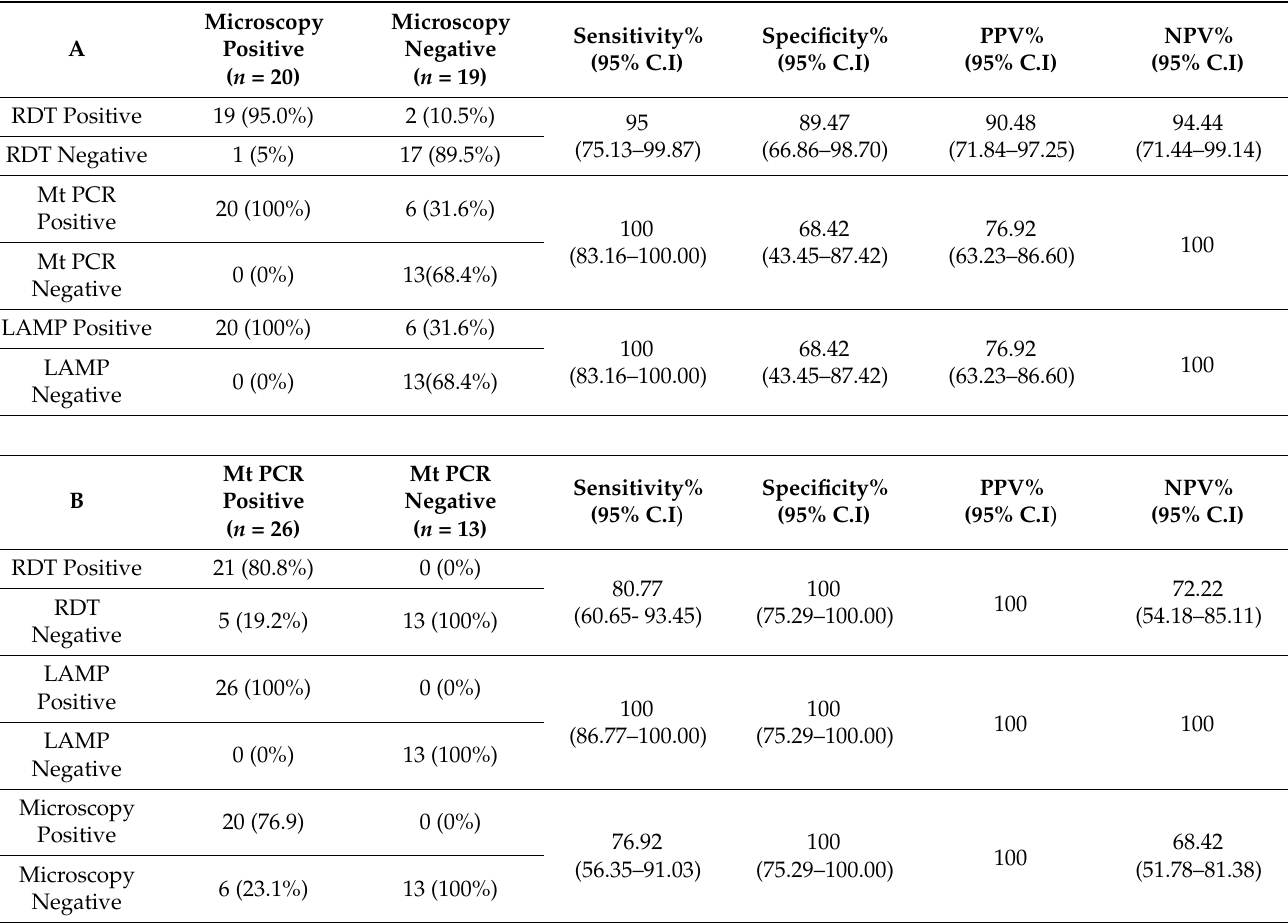
Table 3. Sensitivity and specificity of LAMP compared with microscopy, RDT, and mt PCR. ( A ) Representing data when microscopy is treated as the gold standard, and ( B ) when the molecular method PCR is treated as the gold